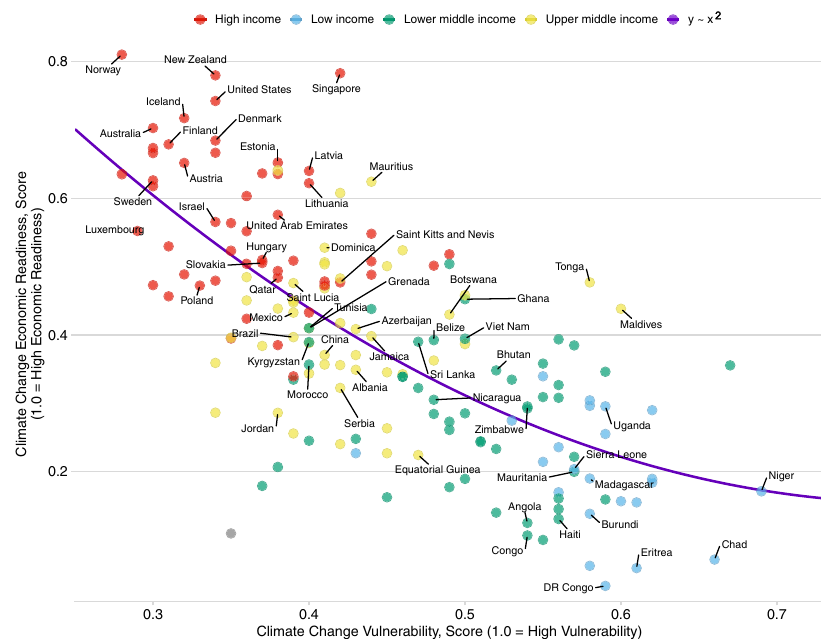
Fig. 11 Relationship between climate change economic readiness and climate change vulnerability. This plot captures income convergence (i.e., high income, low income, lower middle income, and upper middle income) of sampled economies based on average annual